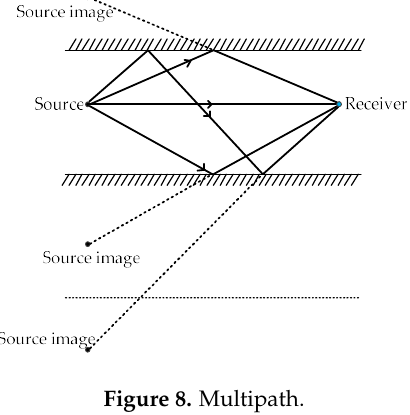
Figure 8. Multipath. Figure 8.